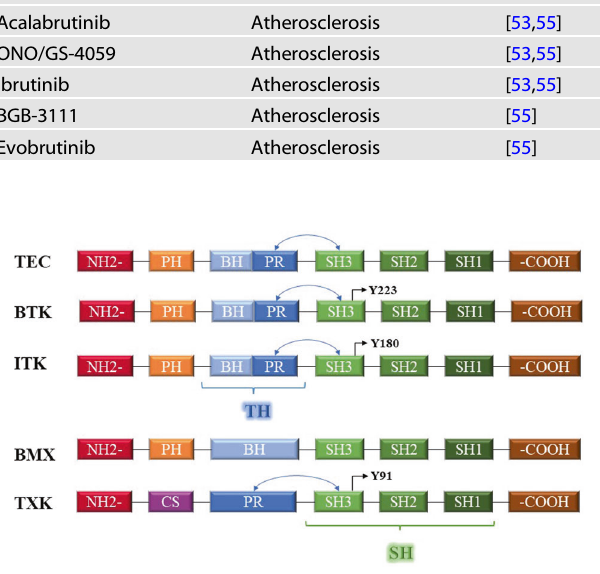
Fig. 2 Schematic representation of Tec family kinases and their domains. PH pleckstrin homology, CS cysteine, BH Btk homology, PR proline-rich, TH Tec homology, SH Src homology, Y223, Y180, Y91 autophosphorylation sites; The PR motif can bind to the SH3 domain in an intramolecular